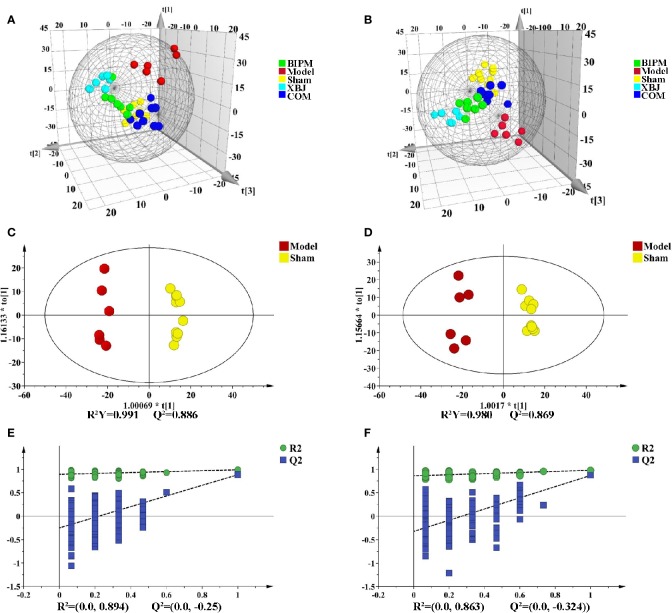
PLS-DA and OPLS-DA score plots in positive and negative ion modes. PLS-DA score plots of different groups in positive (A) and negative (B) ion modes. OPLS-DA score plots for Model group vs. Sham group in positive (C) and negative (D) ion modes. Permutation tests obtained from Model group vs. Sham group in positive (E) and negative (F) ion modes. PLS-DA, partial least-squares discriminant analysis; OPLS-DA, orthogonal partial least-squares discriminant analysis.